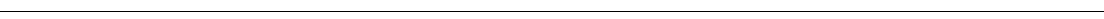
Fig. 4 Analysis of UFD-2 substrate speci fi city. a UFD-2-mediated ubiquitination of UNC-45 Δ UCS , UNC-45 GST-UCS , UNC-45 Δ TPR , and UNC-45 E781K in comparison to the wild-type, full-length protein. b Plotted lane pro fi les of ubiquitination reactions shown in panel a . Mono- and di-ubiquitinated species are indicated for the deletion constructs. c Pull-down studies showing the interaction of UFD-2 with different UNC-45 proteins. d Cartoon representation of UNC-45 (PDB code: 4i2z) with TPR, central, neck, and UCS domains colored in green, orange, yellow, and gray, respectively. Ubiquitination sites identi fi ed in MS experiments are shown as colored spheres (green: residues bordering the myosin-binding canyon; magenta: residues near the C terminus of the UCS domain; and yellow: residues close to the fl exible UCS loop). e Upper panel: 60 and 75 min time points of UNC-45 KR ubiquitination reactions with proteins that have been pre-incubated for 60 min at 30 °C were analyzed by anti-UNC-45 western blot. Lower panel: plotted lane pro fi les of the 60 min time point of the ubiquitination reactions, presented in two graphs for